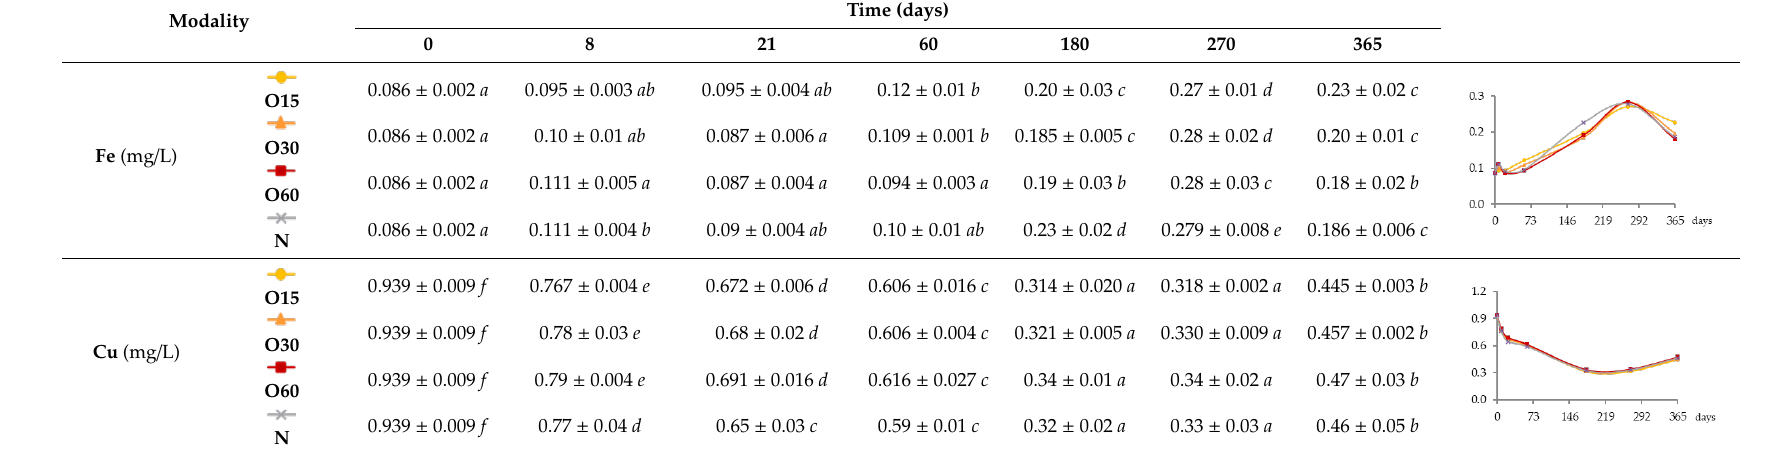
Table 1. Contents of iron and copper in the aged WSs according to the ageing modalities and the ageing time.